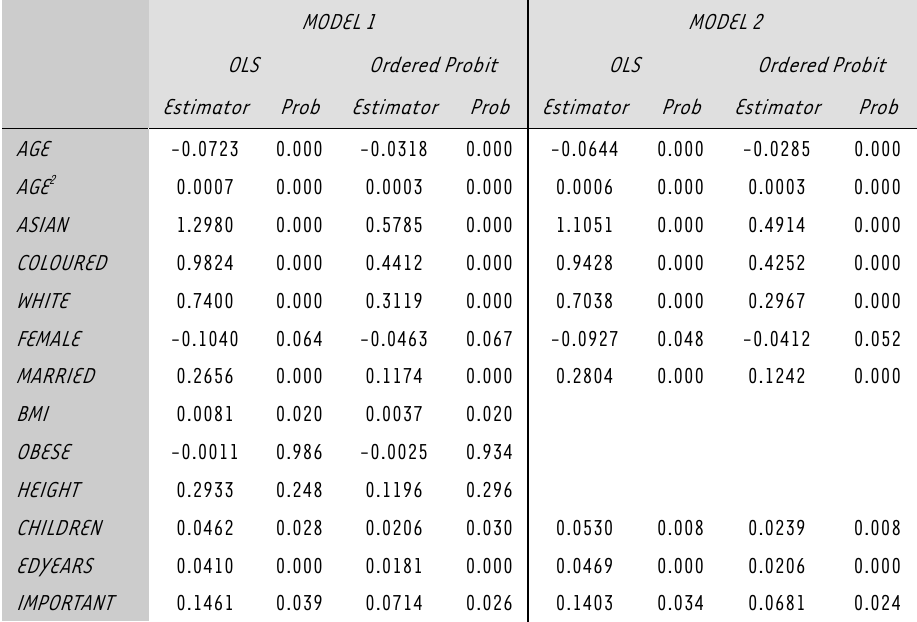
Initial estimated well-being functions MODEL 1 MODEL 2 OLS Ordered Probit OLS Ordered Probit Estimator Prob Estimator Prob Estimator Prob